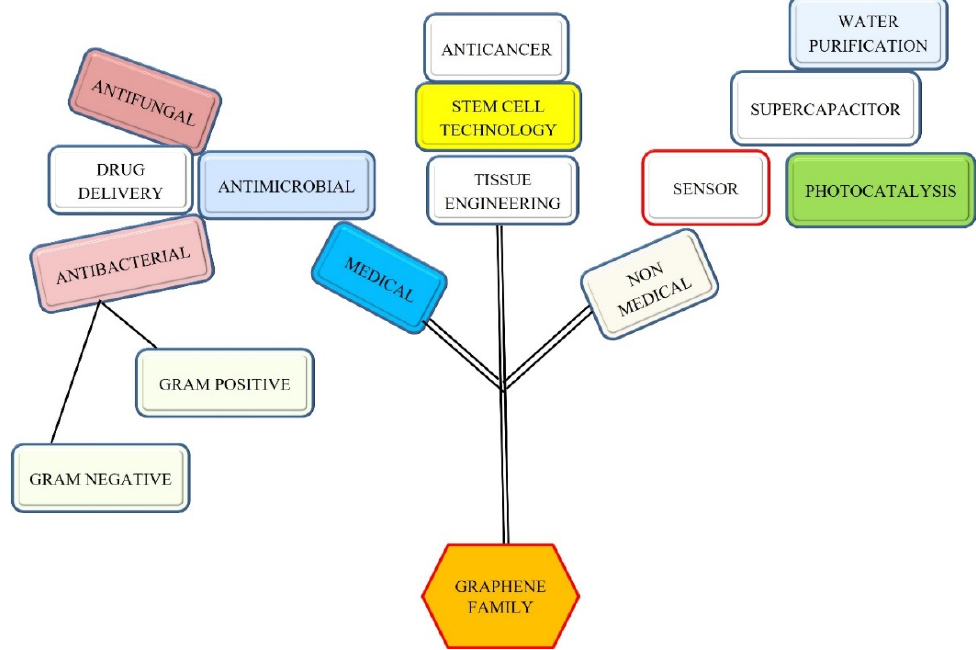
Figure 1. Potential applications of GN-based nanomaterials in different fields.